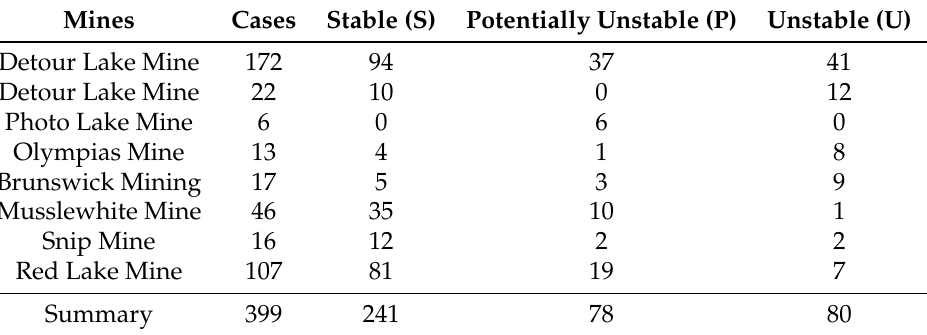
Table 2. Case histories’ data sources